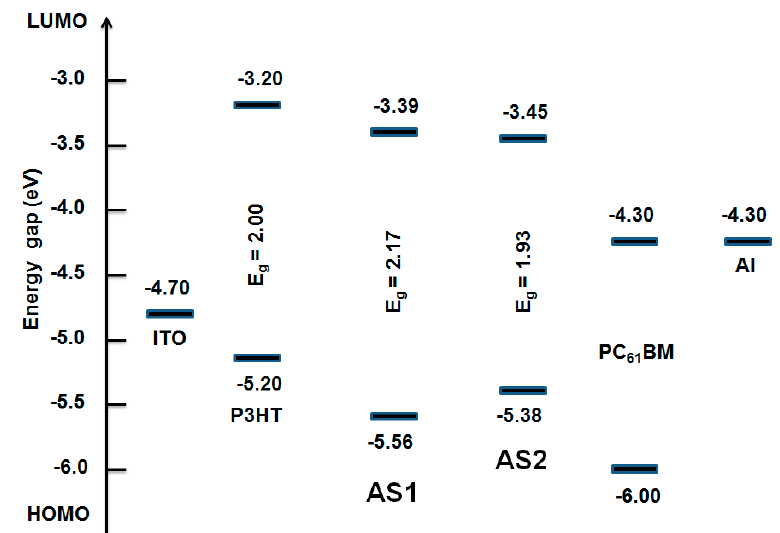
Figure 6. Energy level diagram depicting the band gaps of AS2 and AS1 in comparison with P3HT and PC 61 BM. Experimental estimation of the HOMO energies was carried out using PESA and the LUMO energies were calculated by adding the optical band gap (film spectra) to the HOMO values.